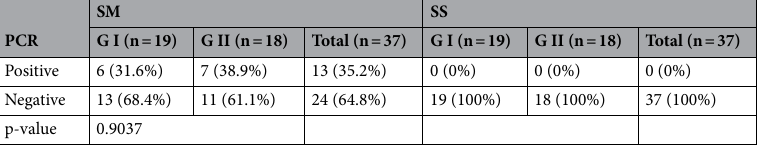
Table 3. Absolute and relative frequency (%) of individuals with the presence and absence of the bacteria Streptococcus mutans and Streptococcus sobrinus in groups I and II. GI group with gastrostomy, GII group without gastrostomy, PCR polymerase chain reaction, SM Streptococcus mutans, SS Streptococcus